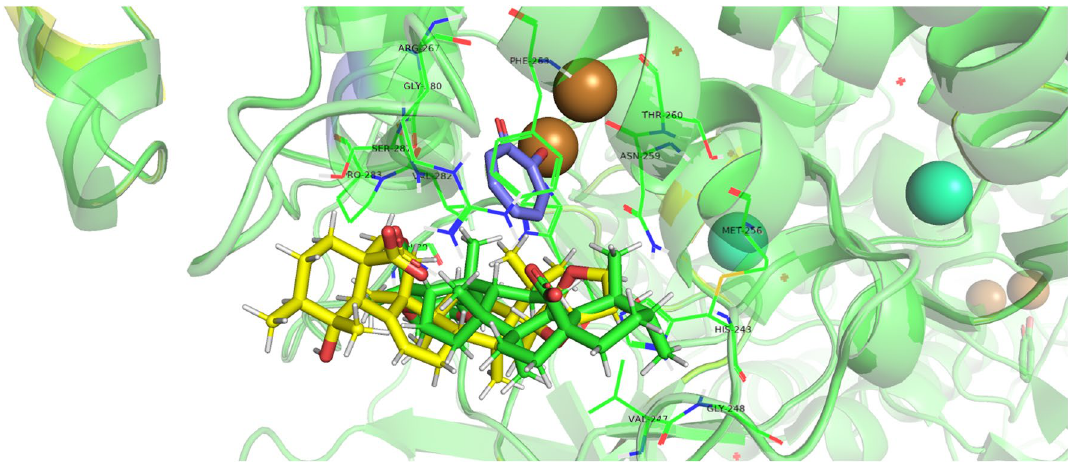
Figure 6. Visualization of tyrosinase binding site using PyMOL. Magenta = cocrystal; green = compound 1; yellow = compound 2.